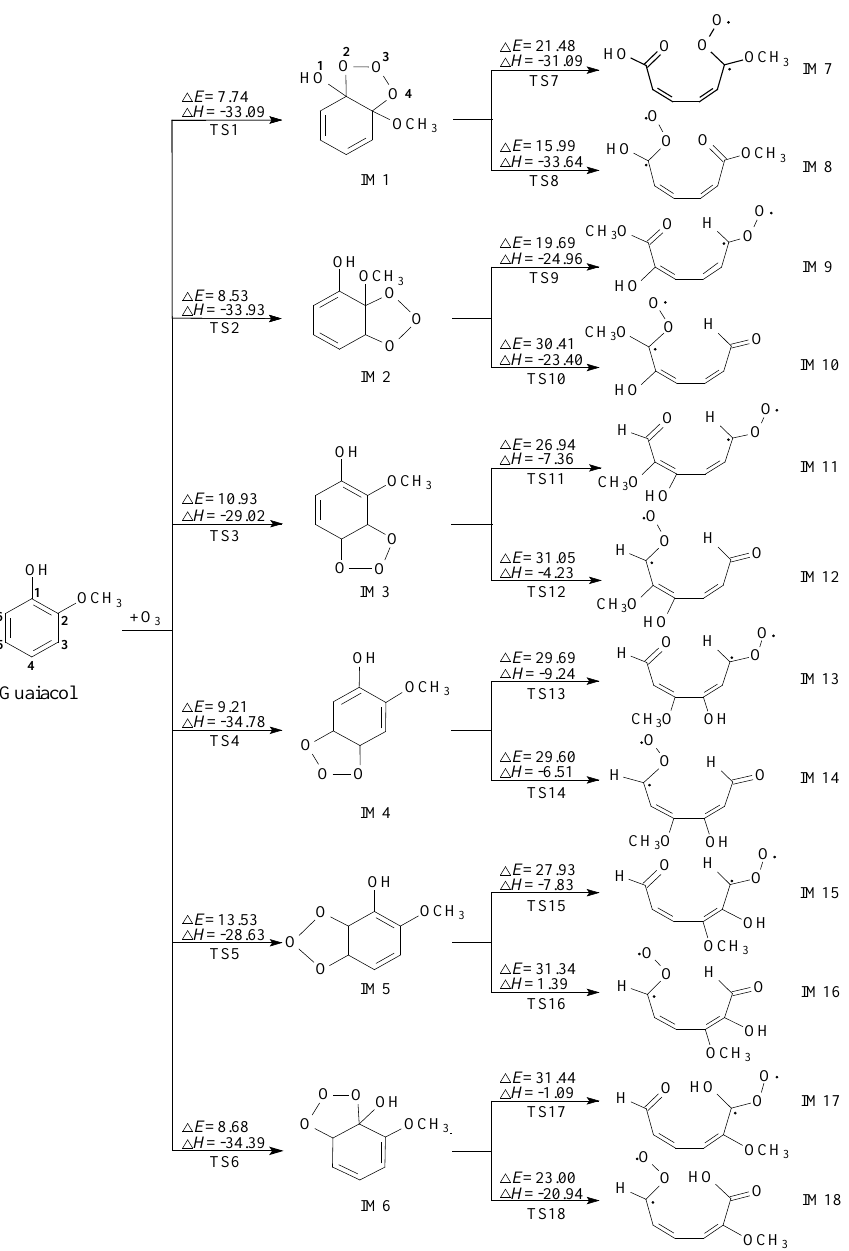
Figure 2. The initial reaction routes of ozone with guaiacol, ∆ E : potential-energy barriers, ∆ H : heats of reaction, TS: transition state, IM: intermediate.